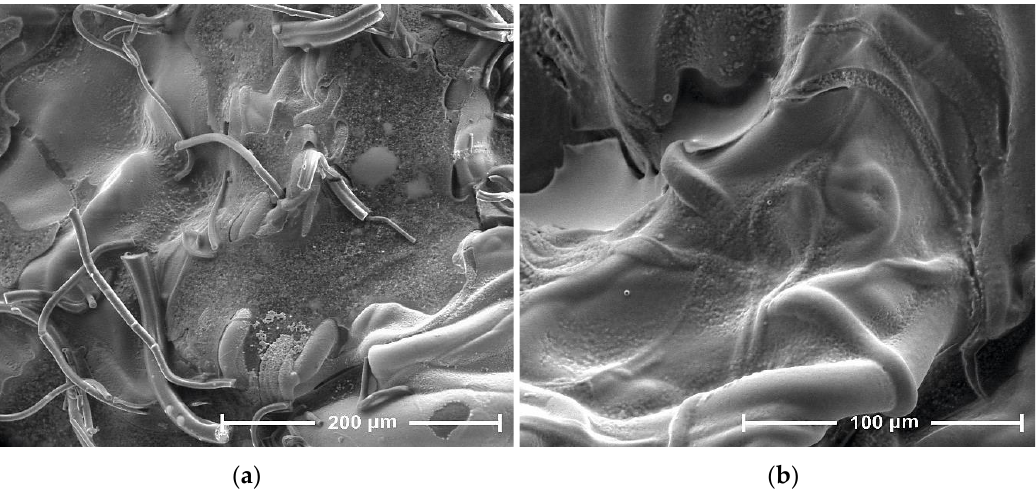
Figure 6. SEM images of PLA-ALG-Zn (2+) , magnification: ( a ) 800× and ( b ) 1600×.